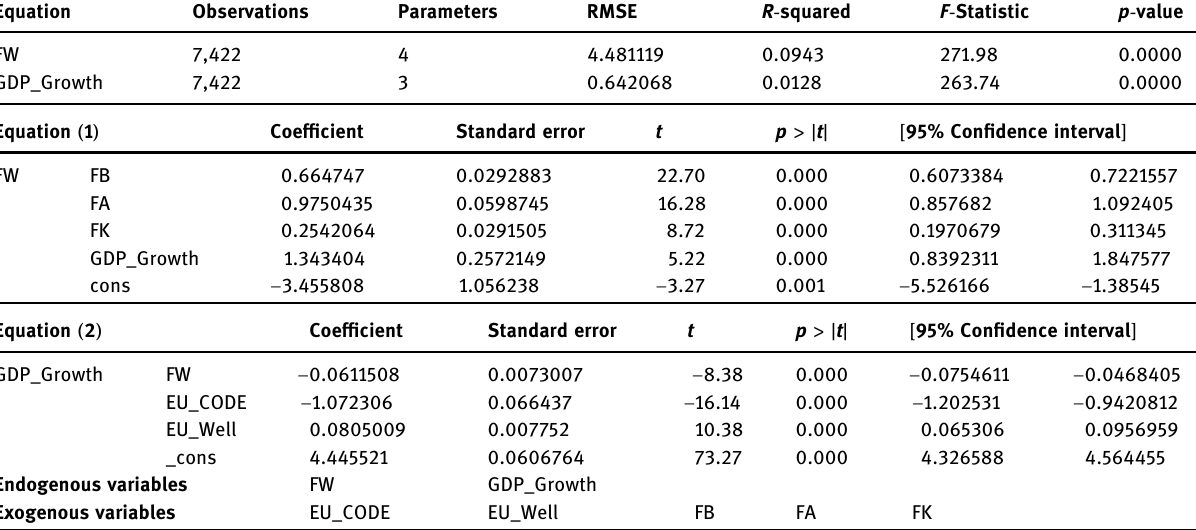
Table 10: Two - stage least - squares regression Equation